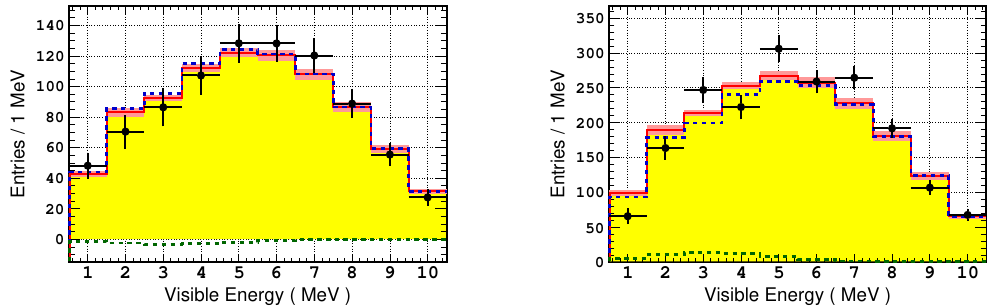
Figure 5 . The ND (left) and FD (right) visible energy spectra of the 9 Li+ 8 He data (black points). Overlain are the best (cid:12)t results with 9 Li (blue dashed line), 8 He (green dashed line), and their sum (solid red line). The pink error bands represent the uncertainty on the predicted spectrum.